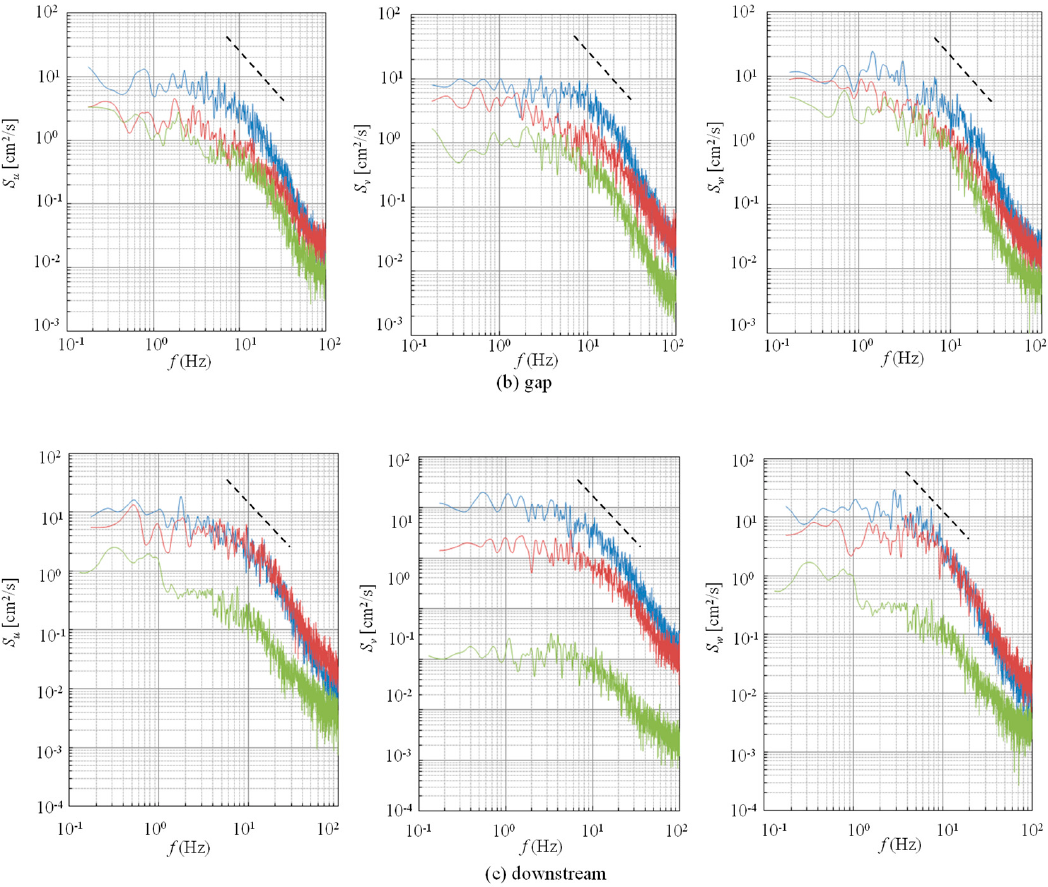
Figure 18. Energy spectral for developing scour holes at the ( a ) upstream, ( b ) gap and ( c ) downstream of the pile group.